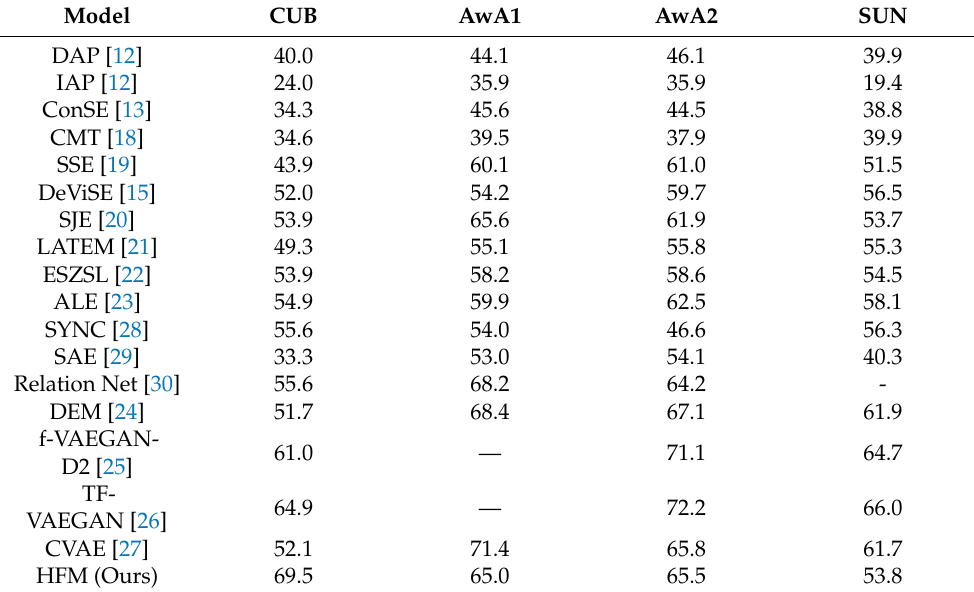
Figure 5. This figure visualizes the image feature space of the AwA-1 dataset (each color denotes a label), ( a ) shows t-SNE real test data visualization and ( b ) shows the test data generated from the proposed approach. Table 1. State-of-the-art comparison on four datasets using the per-class average under the ZSL